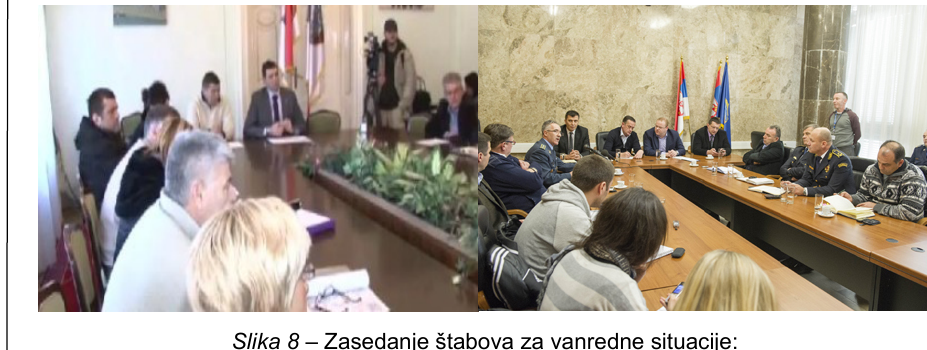
Figure 8 – Session of headquarters for emergency situations: a) The District and the City HQ, b) the Republic